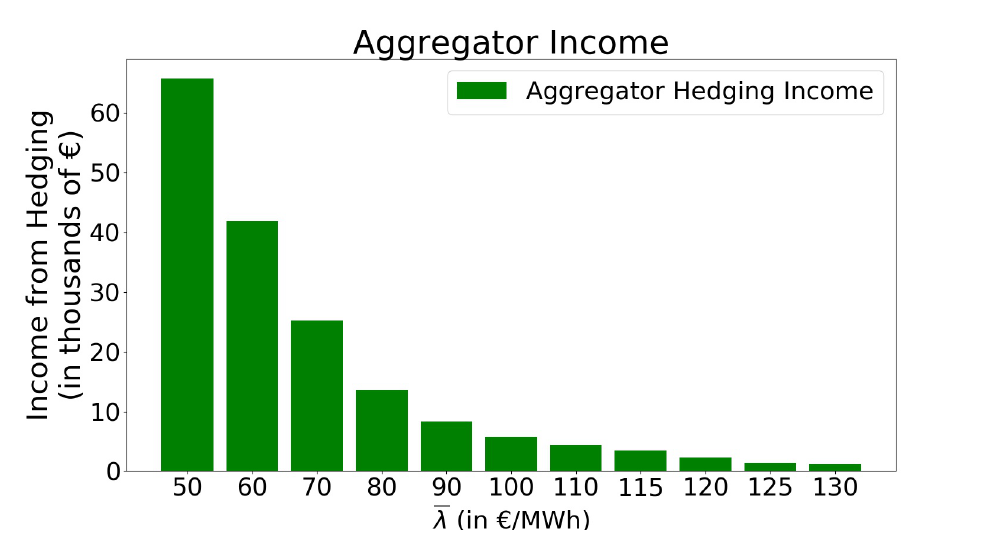
Figure 8. Aggregator income from hedging under different contractual